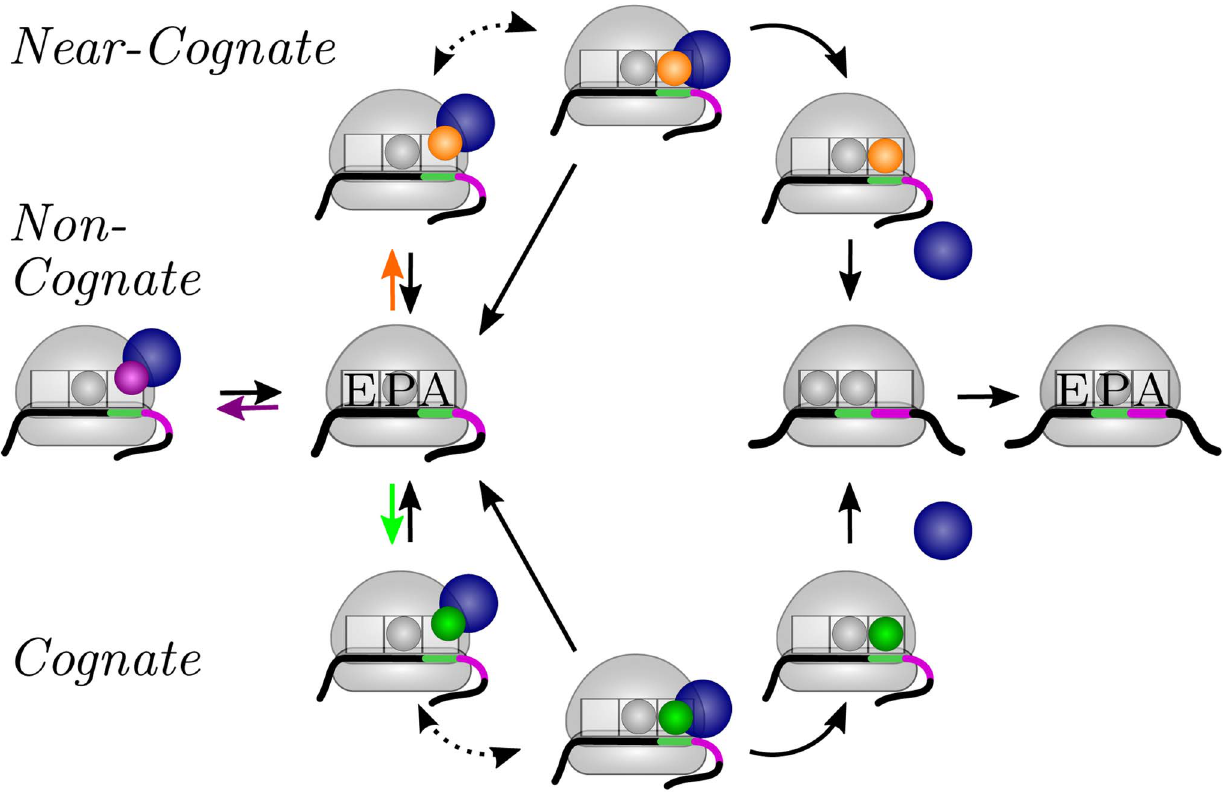
Figure 1. Elongation cycle of a ribosome (gray dome) translating an mRNA (black-green-purple line). Aminoacyl-tRNA (small gray, green, purple, or orange sphere) is delivered to the ribosome in a ternary complex with the elongation factor EF-Tu (larger blue sphere) and GTP (not shown). In addition to the initial binding site, the ribosome has three tRNA binding sites, the A, P, and E sites. The elongation cycle of translation starts when the A site of the ribosome has arrived at a new codon (green) of the mRNA. The ribosome then binds a ternary complex with a tRNA that may be cognate, near-cognate, or non-cognate to this codon. As a consequence, the elongation cycle exhibits three different branches corresponding to three different reaction pathways: (left) A non-cognate ternary complex is again released from the initial binding site of the ribosome; (top) A near- cognate ternary complex is usually rejected but is very rarely used to elongate the peptide chain; and (bottom) A cognate ternary complex may also be rejected but is typically used for elongation of the peptide chain. The two dotted arrows correspond to additional intermediate states and transitions as explained in more detail in Fig. 3 below.